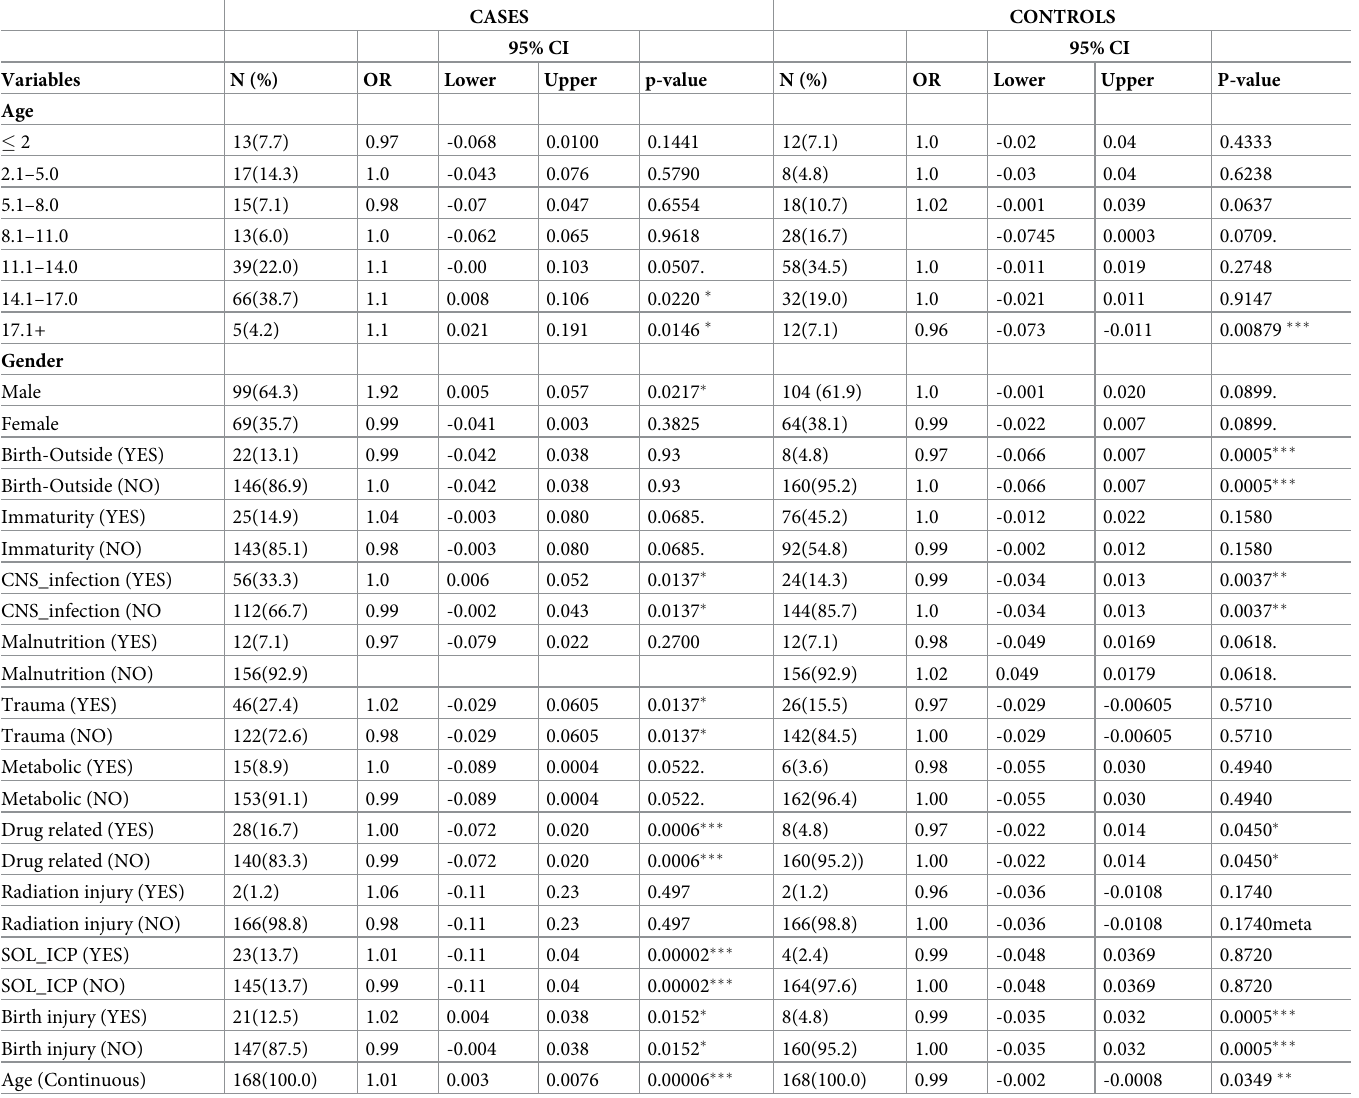
Table 1. Factors driving the occurrence childhood brain atrophy in Northern Tanzania. Simple logistic regression analysis showing demographic and non-demo- graphic factors responsible for childhood brain atrophy. Most of non-demographic factors including CNS infection, trauma, convulsions and drugs, SOL&ICP and birth injury are influential independent variables. Upper extreme of age and male gender are significant among demographic